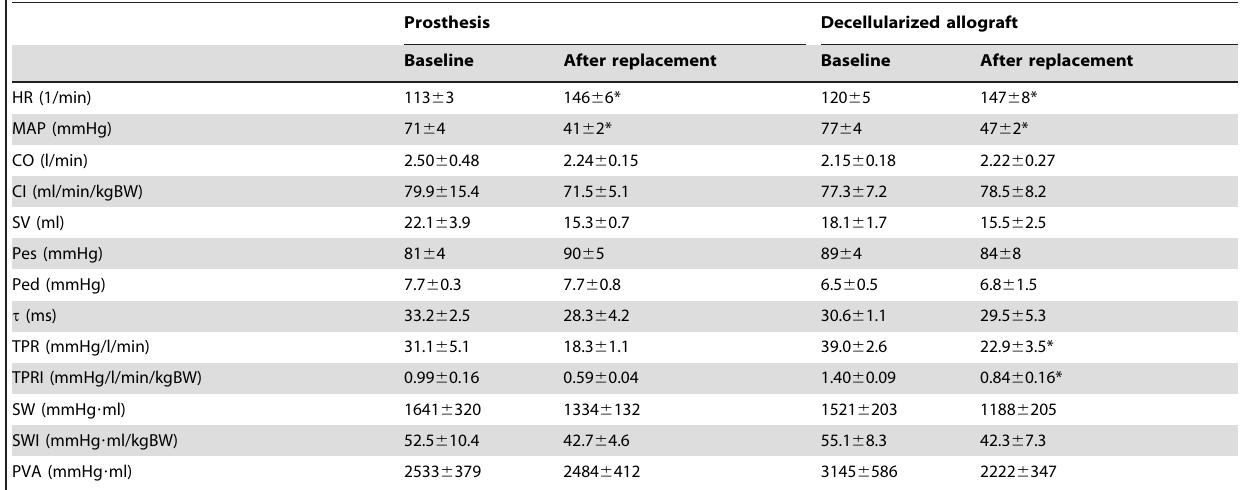
Table 1. Basic hemodynamic